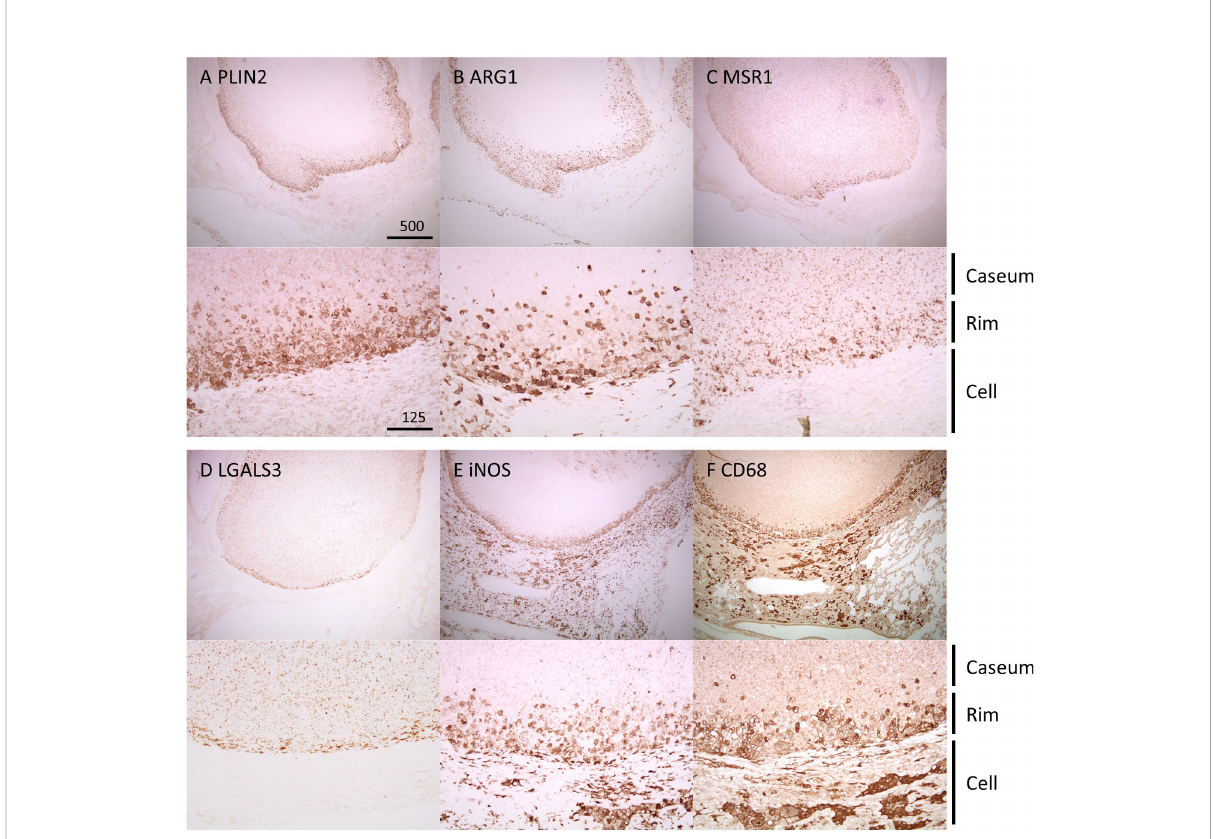
FIGURE 3 Localization of Rim signatures within necrotic granulomas. IHC was performed to stain necrotic granulomas at 8 weeks p.i. for Rim signatures of PLIN2 (A) , ARG1 (B) , MSR1 (C) , and LGALS3 (D) . IHC images for the M1 macrophage markers iNOS (E) and CD68 (F) are also shown. The lower panels are enlarged images of the upper panels. The regions corresponding to Caseum, Rim, and Cell of necrotic granulomas are